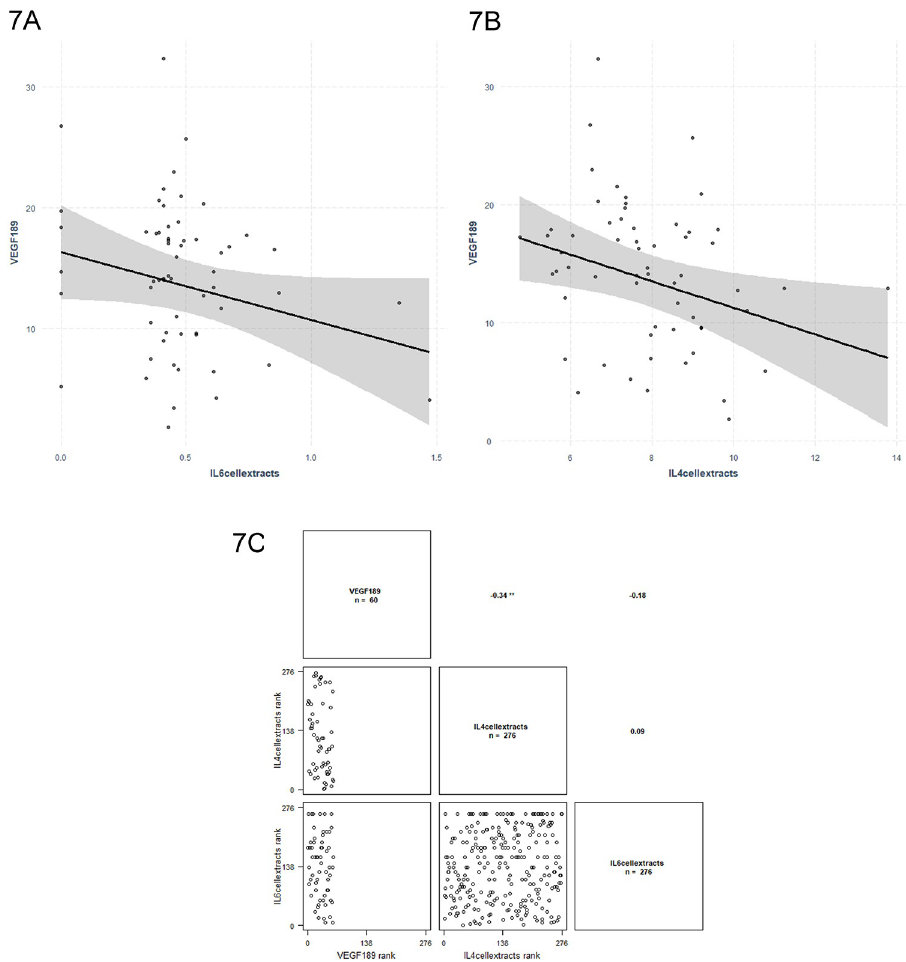
Fig 7. Regression graphs for VEGF isoform mRNA levels as dependent variable and IL-6 (7A) and IL-4 (7B) 189 cellular extracts levels as independent variables. The related correlation graph is presented in (7C).